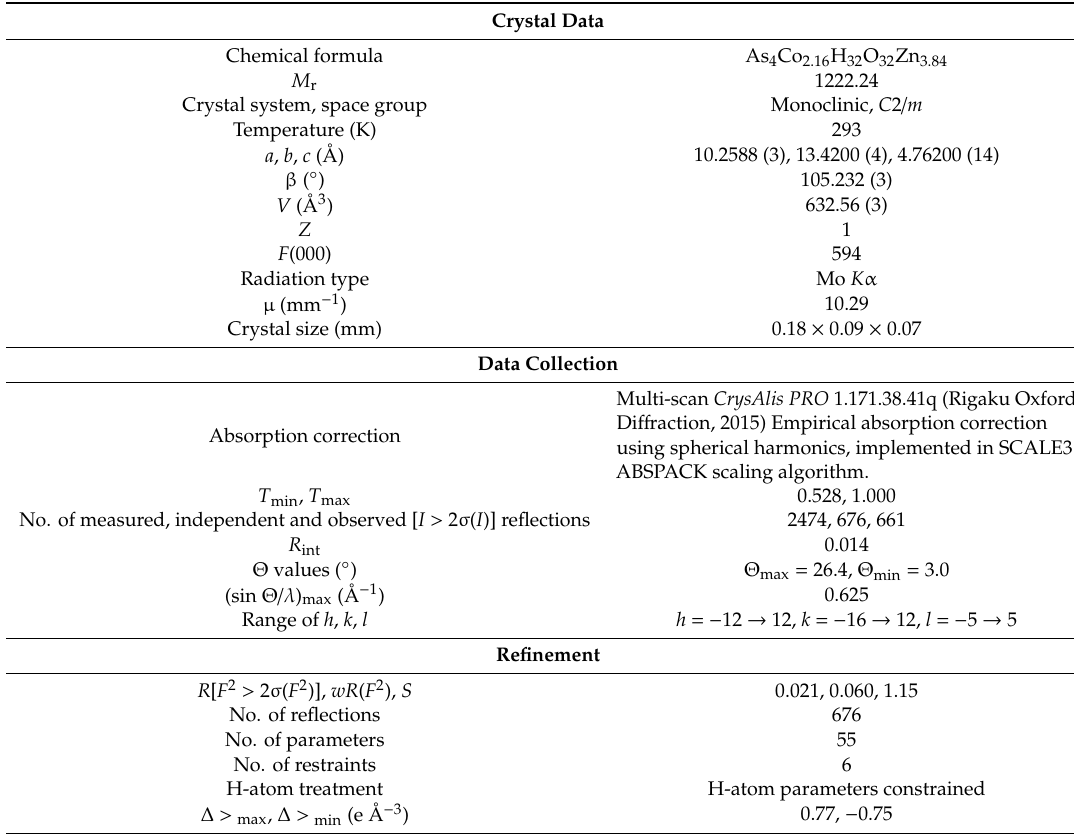
Table 2. Crystal data, data collection, and structure